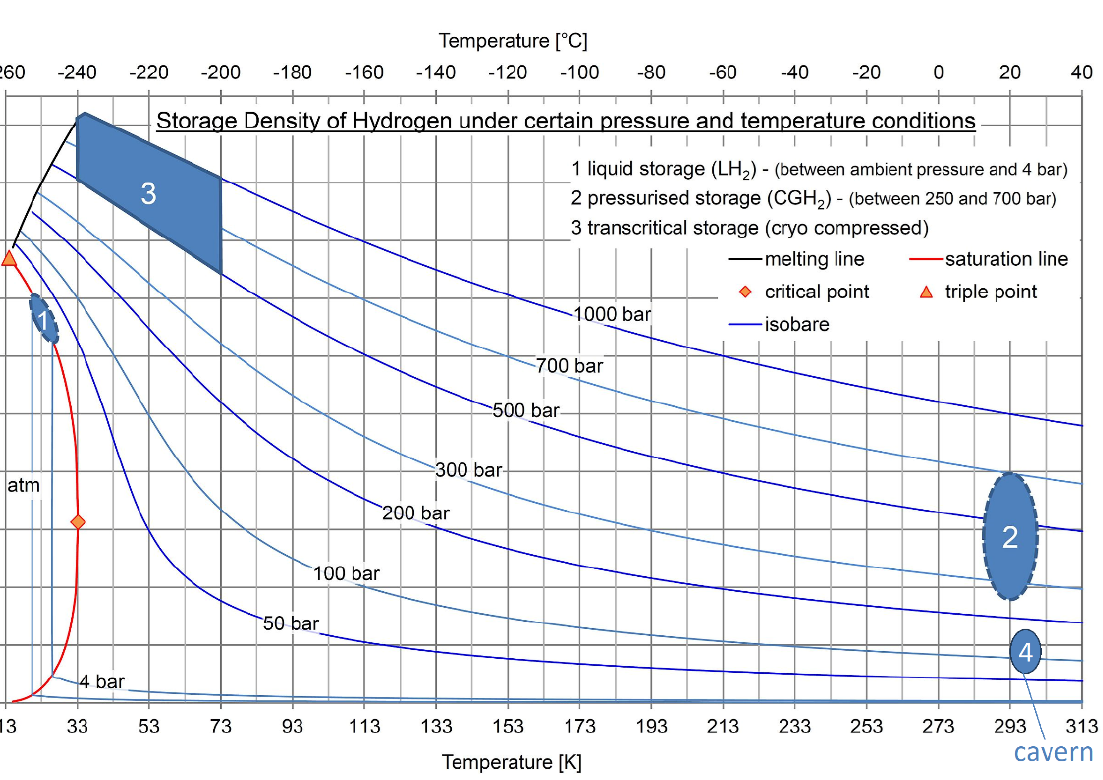
Figure 1. Density of hydrogen under different pressures and temperatures (reprinted with permission from Ref. [38]. Copyright 2012 ILK Dresden, Moritz Kuhn. CC BY-SA 4.0).